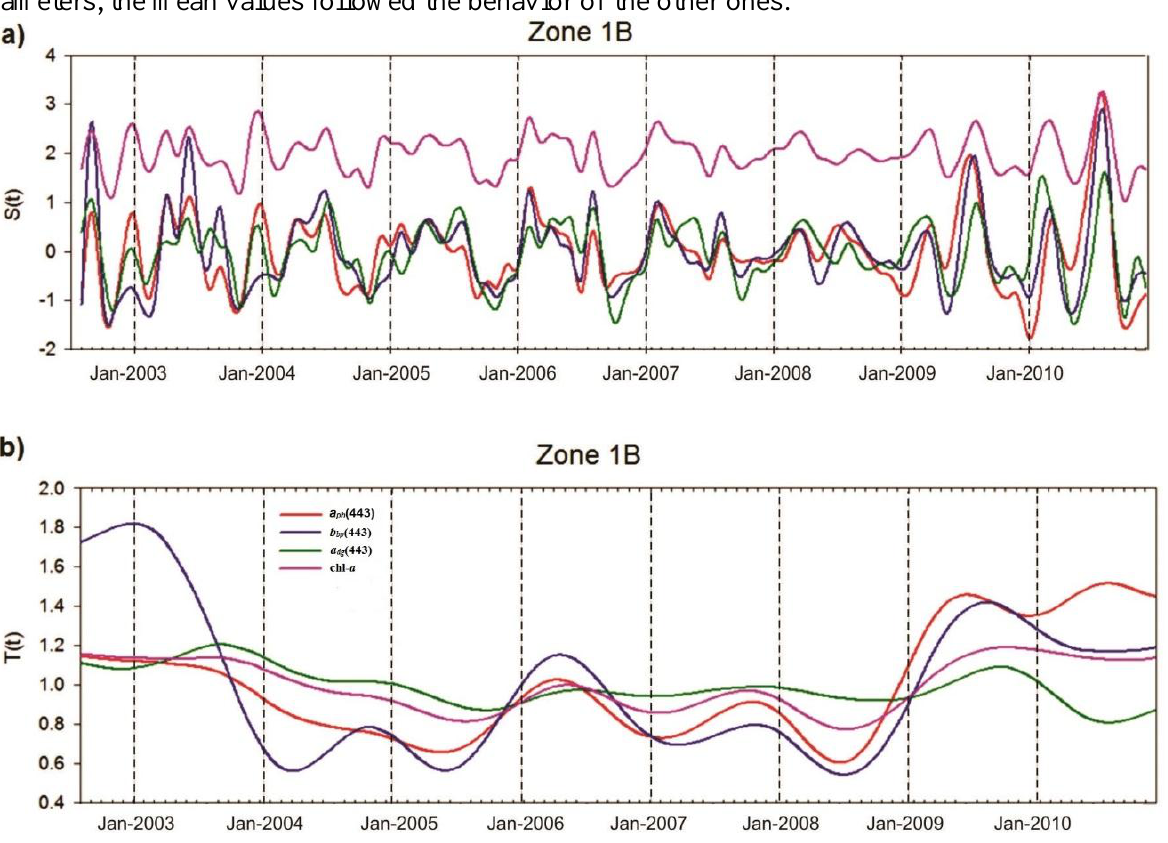
Figure 8. X-11 terms statistics of a ph (443) , b bp (443) , a dg (443), and chl- a in the zone of interest 1B . (a) S(t) (seasonal term); (b) T(t) trend term. (2) Inner